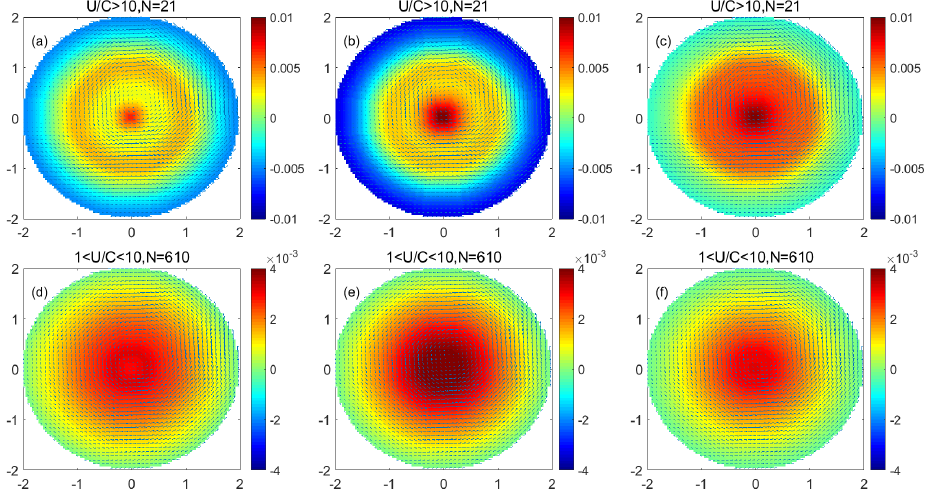
Figure 6. ( a − c ) are the monopole distribution of microplankton, nanophytoplankton, and picophy- toplankton in the high nonlinear cyclonic eddy, respectively; ( d − f ) are the monopole distribution of microplankton, nanophytoplankton and picophytoplankton in the low nonlinear cyclonic eddy, re- spectively. (Unit: mg/m 3 ).